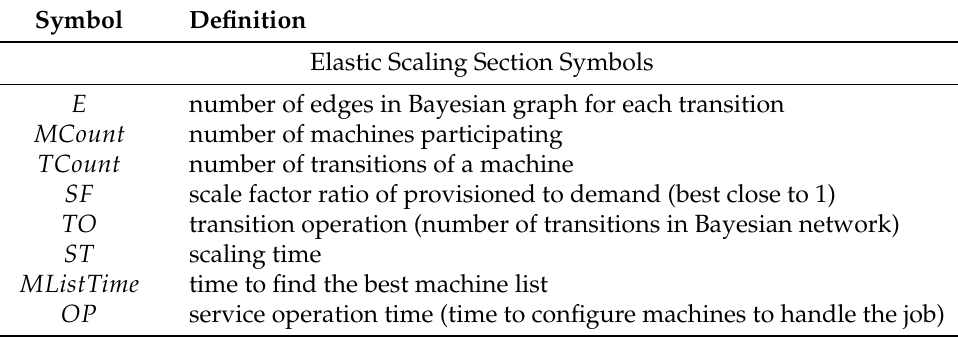
Table 5. Key Symbols Used in the Analysis and Their